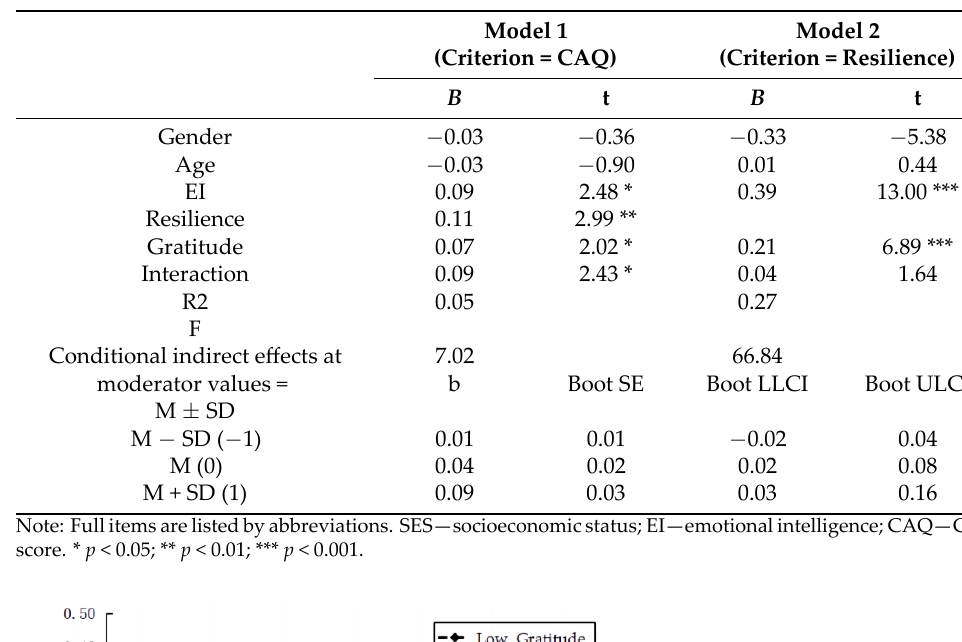
Table 6. Moderated mediating analyses.